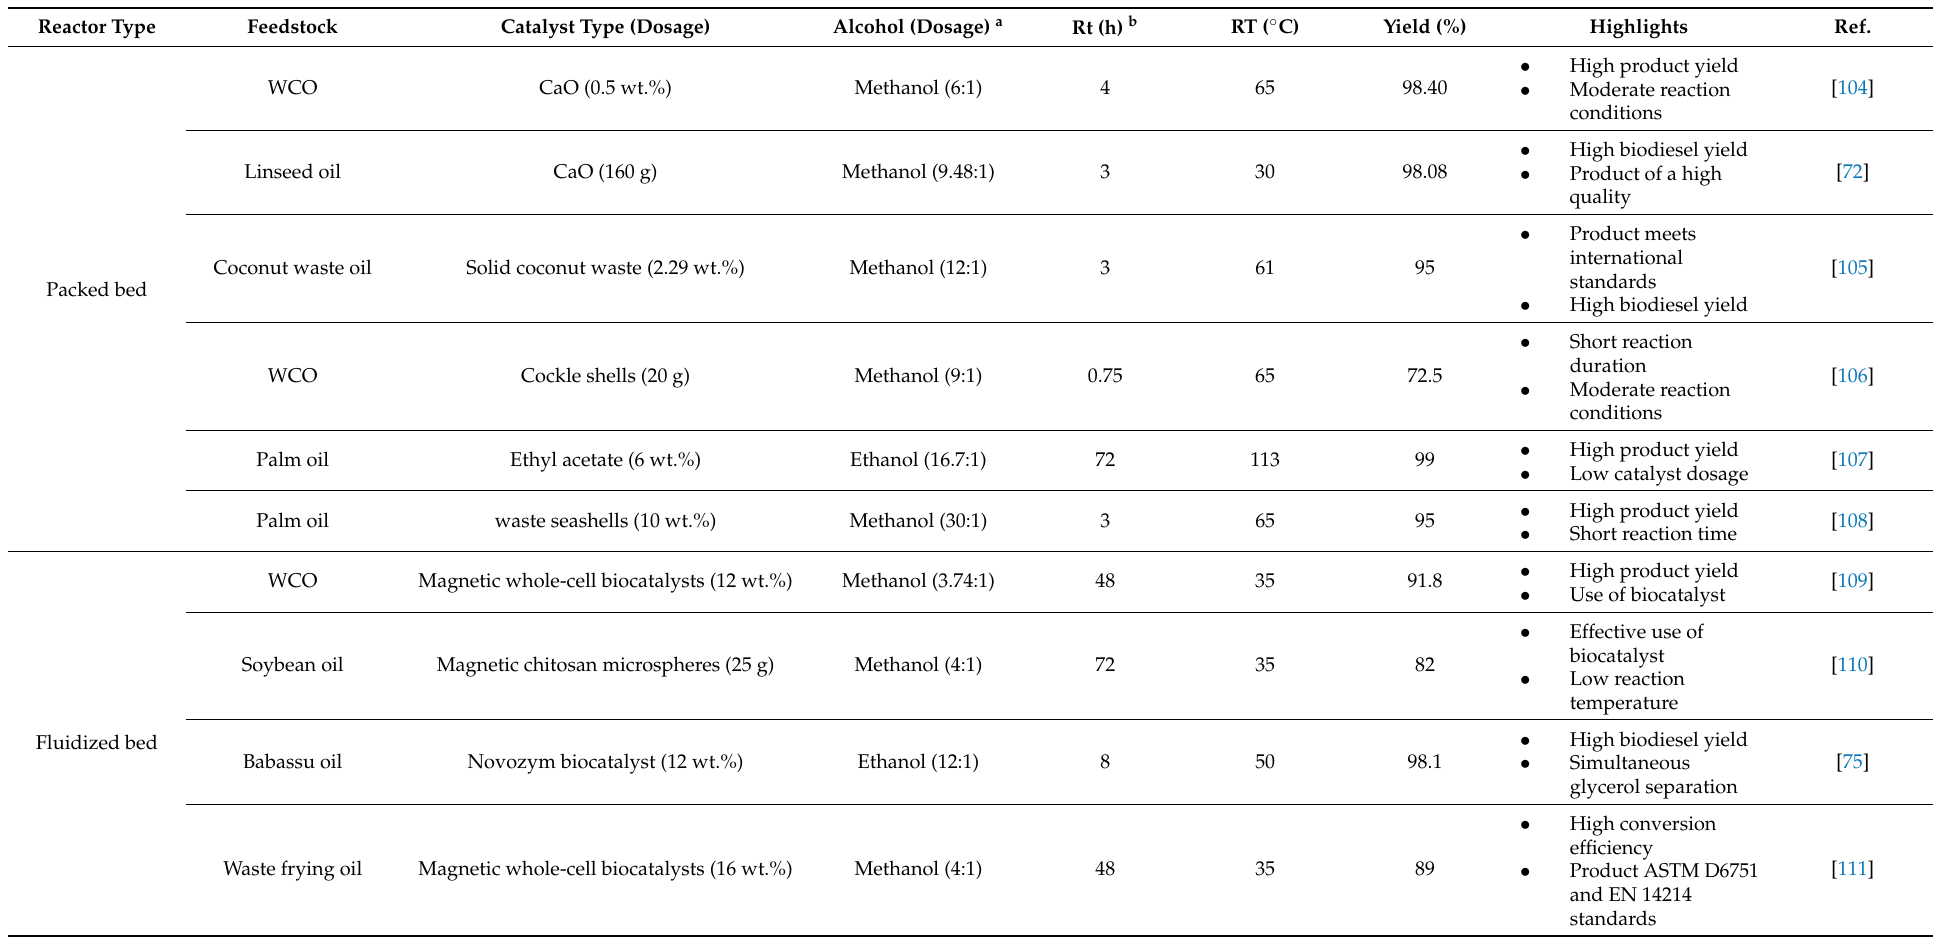
Table 7. Biodiesel production using tubular reactor